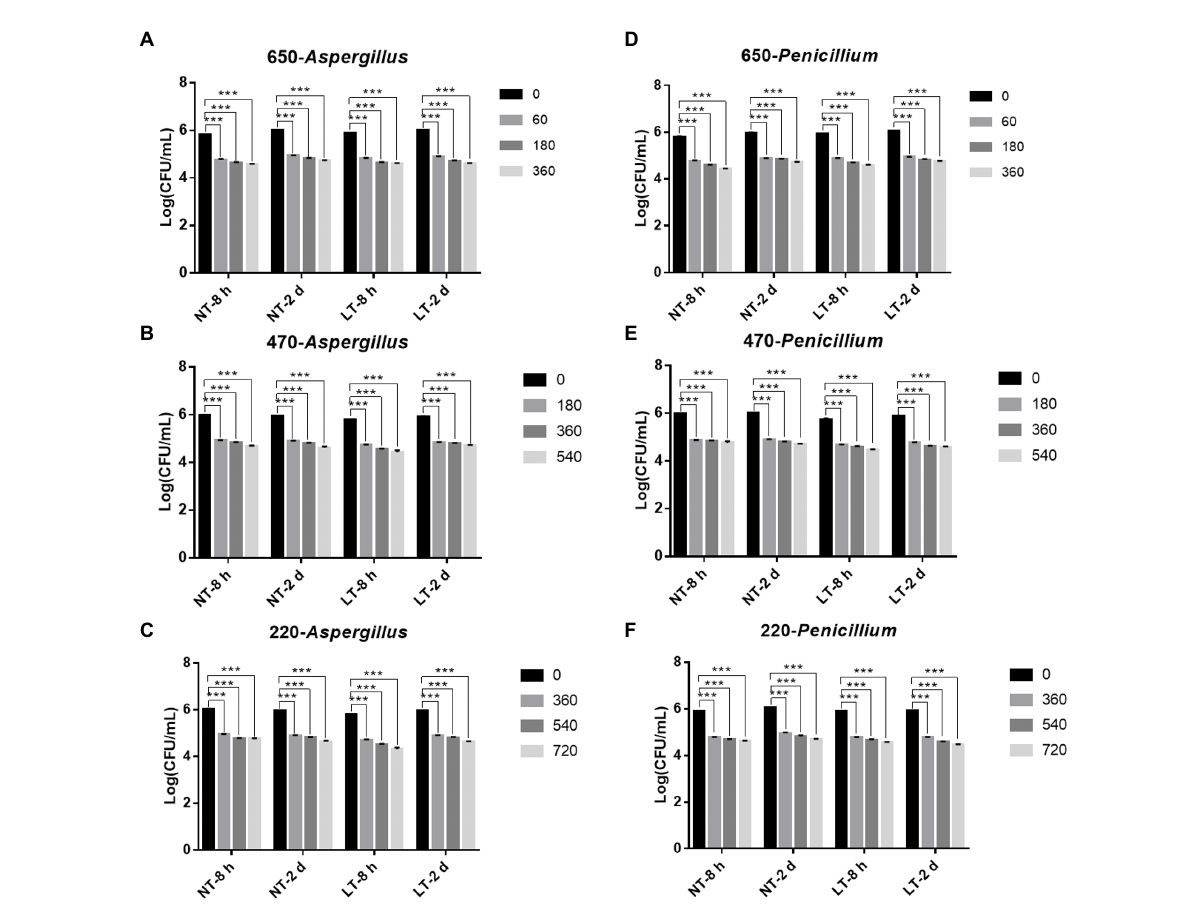
FIGURE 2 IPL sterilization efficiency on biofilm of Aspergillus niger and Penicillium glaucum under different capacitances in the 96 well cell culture plate model. (A–C) IPL sterilization efficiency on biofilm of A. niger . (D–F) IPL sterilization efficiency on biofilm of P. glaucum . (650 μ F: 0.0407 J*cm − 2